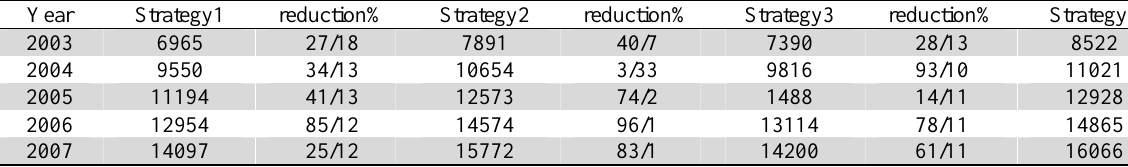
Total costs of empty container repositioning under four